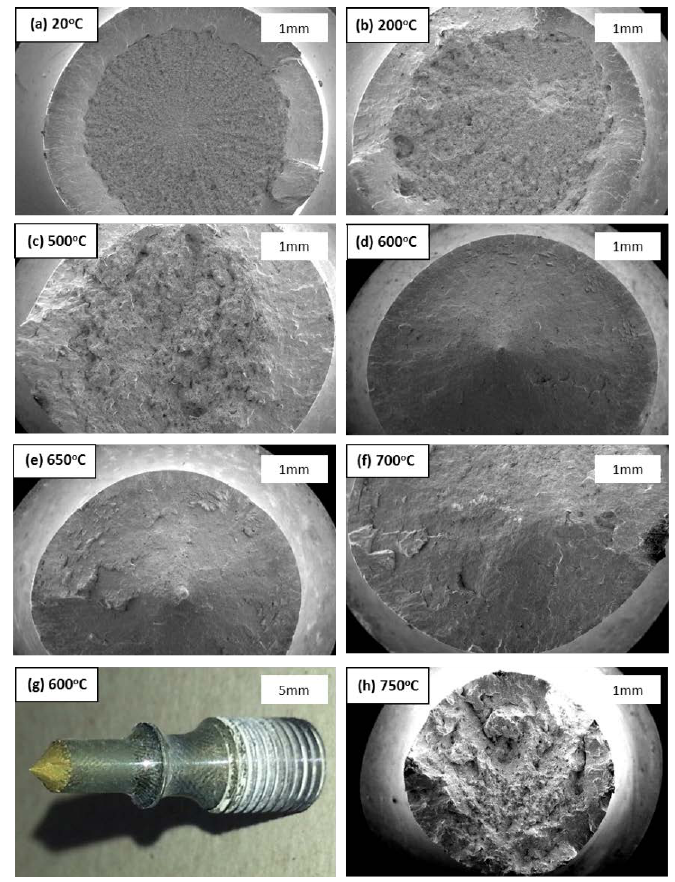
Figure 18. Tensile fracture surfaces indicating: cup and cone fractures at ( a ) 20 °C, ( b ) 200 °C and ( c ) 500 °C; point fractures at ( d ) 600 °C, ( e ) 650 °C, ( f ) 700 °C and ( g ) 600 °C; ( h ) intergranular fracture surface at 750 °C.